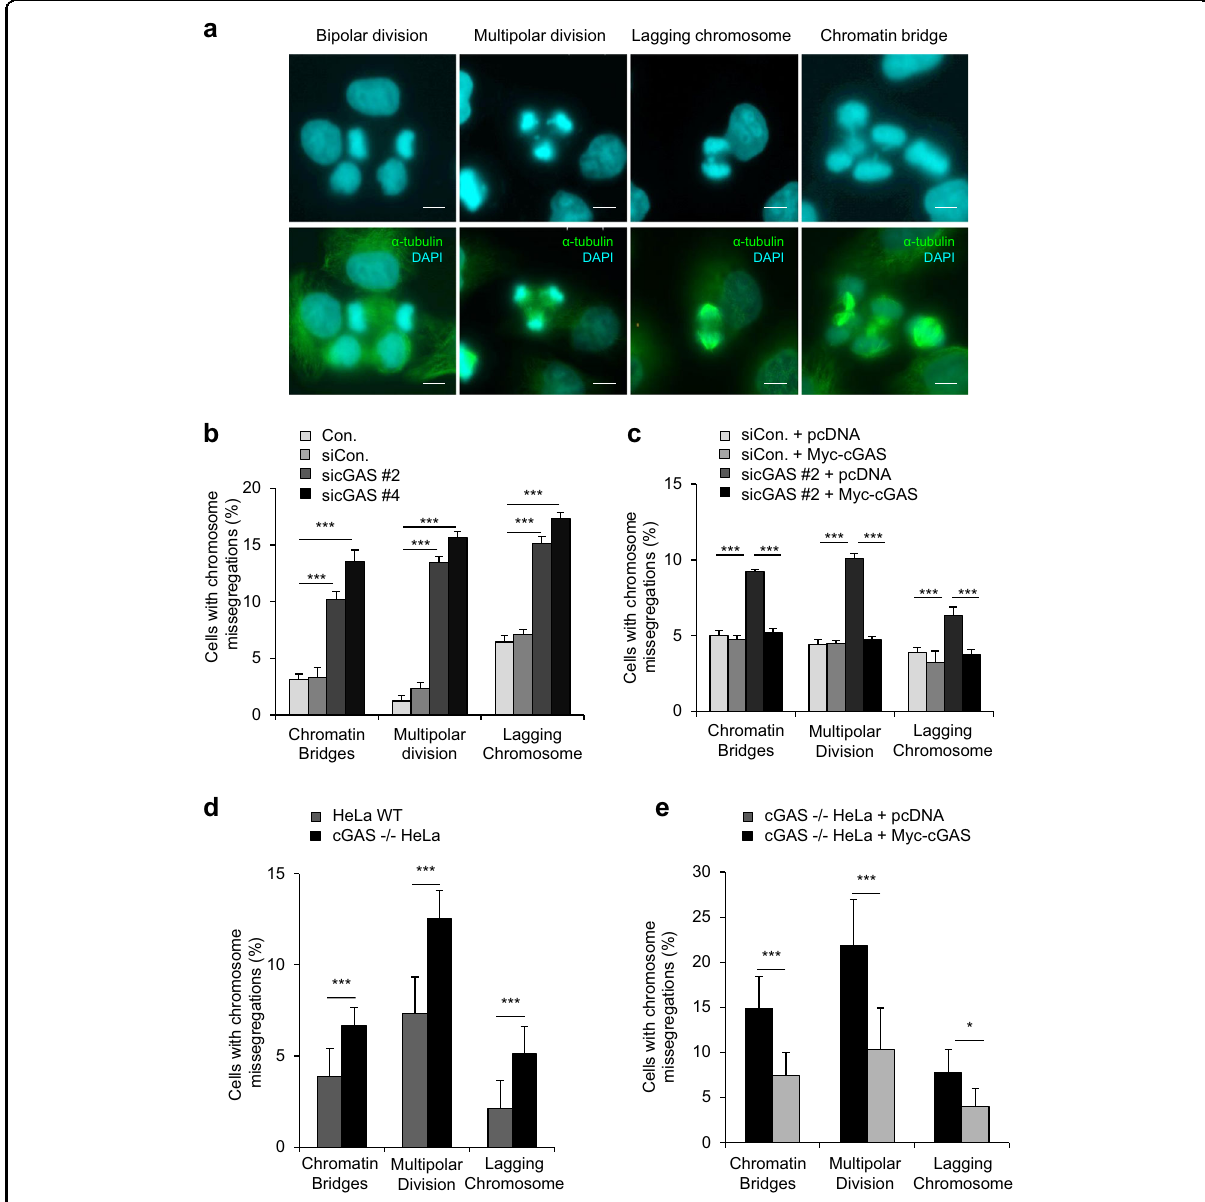
Fig. 2 cGAS is essential to regulate proper chromosomal segregations. a Representative confocal images of mitotic cells 1 h after release from nocodazole-induced mitotic arrest. Cells showing bipolar division, multipolar division, lagging chromosome, and a chromatin bridge (from left to right). b Thirty hours after transfection with sicGAS, mitotic cells were collected by shaking the plate, and they were then treated for 16 h with nocodazole and seeded on a PLL-coated coverslip. After 1 h, cells were fi xed with 100% ice-chilled methanol, and ICC was performed. Cells showing the indicated chromosomal segregation errors were calculated as percentages. The results are given as the mean ± SD from three independent experiments ( n = 300). *** P < 0.001 as assessed by Student ’ s t -test. c Co-transfection of sicGAS with pcDNA or MYC-cGAS (non-targeting siRNA) in HeLa cells for 20 h before beginning treatment with nocodazole, which lasted for 16 h. Cells arrested in mitosis were collected and reseeded on PLL- coated coverslips. After 1 h, the percentage of micronucleated cells was quanti fi ed using ICC. The results are given as the mean ± SD from three independent experiments ( n = 300). *** P < 0.001 by Student ’ s t -test. d cGAS − / − and wild-type HeLa cells were treated with nocodazole for 16 h. Then, mitotic cells were collected by shaking the plate, and the collected cells were seeded on PLL-coated coverslips for 1 h before ICC was performed to analyze the number of cells showing the indicated chromosomal missegregations. The results are given as the mean ± SD from three independent experiments ( n = 300). *** P < 0.001 as assessed by Student ’ s t -test. e cGAS − / − HeLa cells were transfected with pcDNA or MYC-cGAS and then were treated with nocodazole for 16 h to induce mitotic arrest. After release from nocodazole treatment, mitotic cells were seeded on PLL- coated coverslips for 1 h and were then subjected to ICC to quantify the percentage of cells with chromosomal segregation errors. The results are given as the mean ± SD from three independent experiments ( n = 300). * P < 0.05, *** P < 0.001 as assessed by Student ’ s t